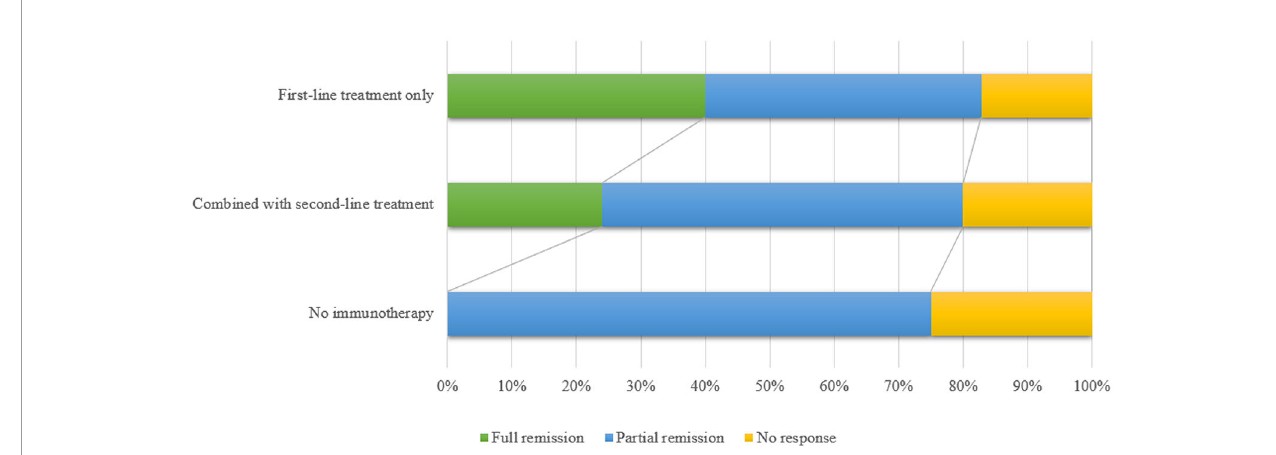
FIGURE 3 | The fi gure shows the comparison of the ef fi cacy between fi rst-line immunotherapy only, fi rst-line immunotherapy combined with second-line immunotherapy and no immunotherapy. Patients without immunotherapy had a relatively poor prognosis. First-line treatments included high-dose steroid pulse therapy, intravenous immunoglobulin and plasma exchange. Main second-line immunotherapy drugs included rituximab, cyclophosphamide and azathioprine. Full remission means the patients returned to baseline; partial remission means the patients showed partial recovery and partial sequelae; no response means patients did not respond to treatment